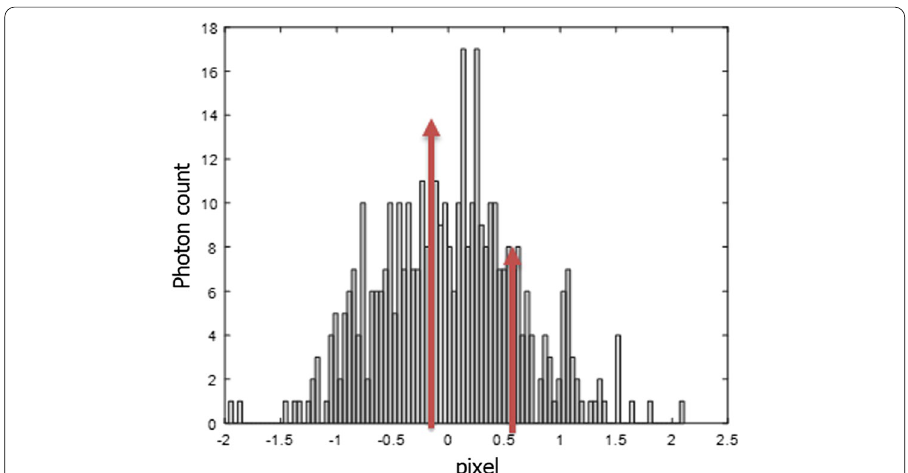
Fig. 1 A typical comparison between stars as Dirac distributions (arrows) and photon counts